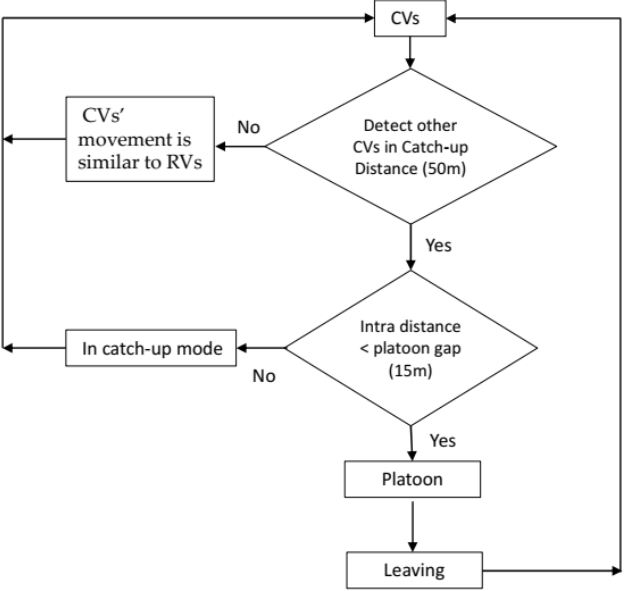
Figure 2. Platoon configuration with Simpla.